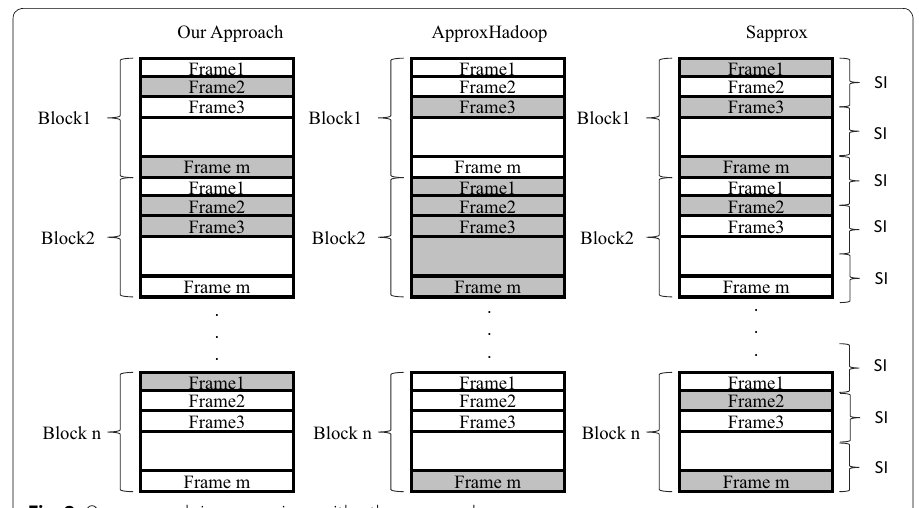
Fig. 2 Our approach in comparison with other